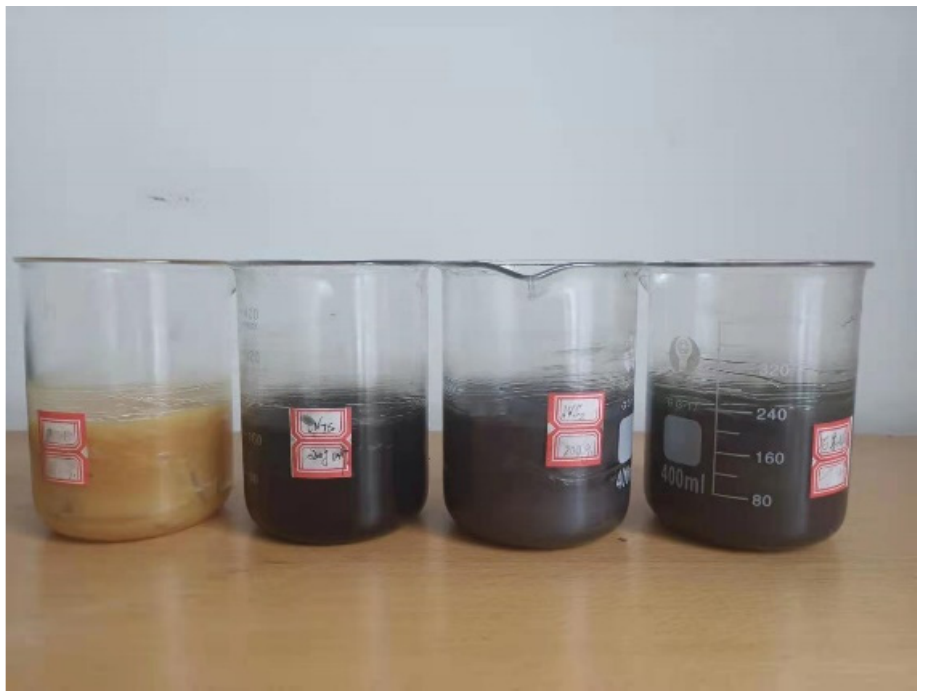
Figure 1. Grease with different additives.